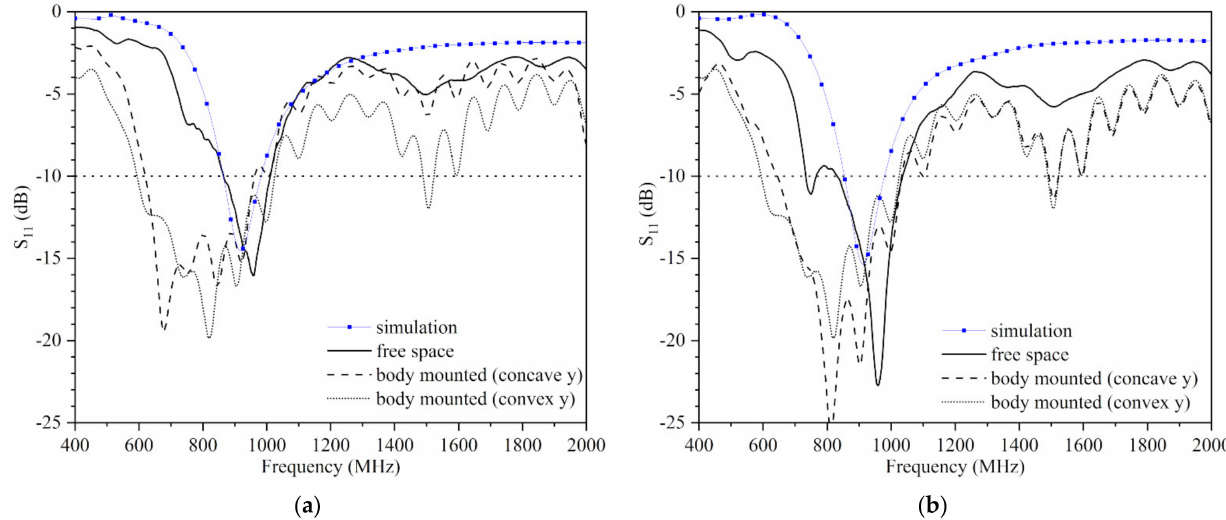
Figure 4. Measured magnitude of S 11 of the bow-tie antenna versus frequency: ( a ) S1Ha (silver hybrid thread) and ( b ) B1Ha (brass hybrid thread) prototype. The effect of human body presence and bending conditions on bow-tie antenna’s S 11 is exhibited: the dashed/dotted curves refer to concave/convex bending of the antenna mounted on human body (measure- ments), while the black solid and the blue marked curves correspond to the planar antenna in free space (measurements and simulations,